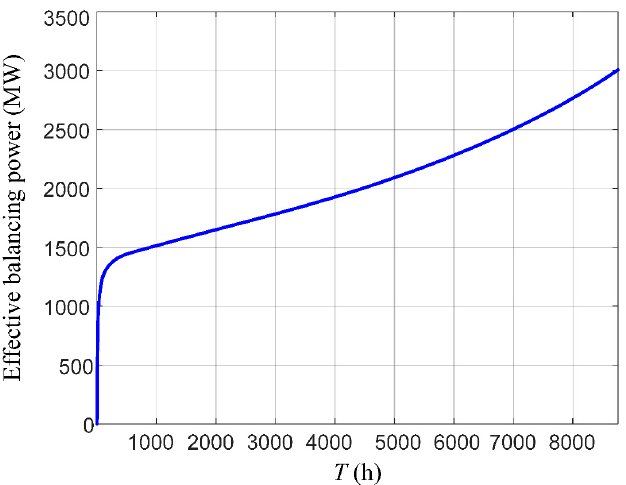
Figure 15. Characteristics of the imbalance profile variability in the optimal RES development sce- nario